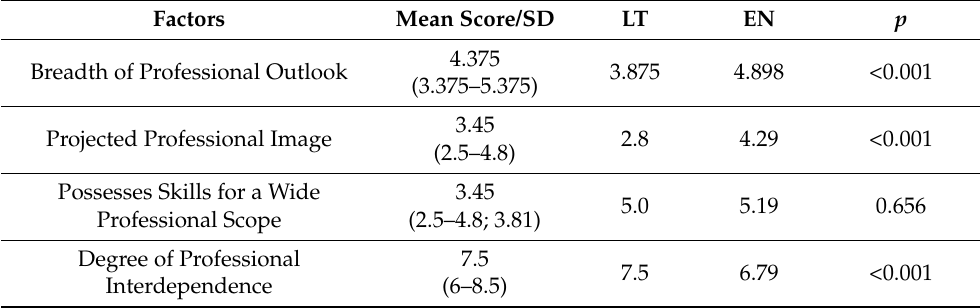
Table 3. Mean scores of factors related to medical students’ attitudes of the role of the